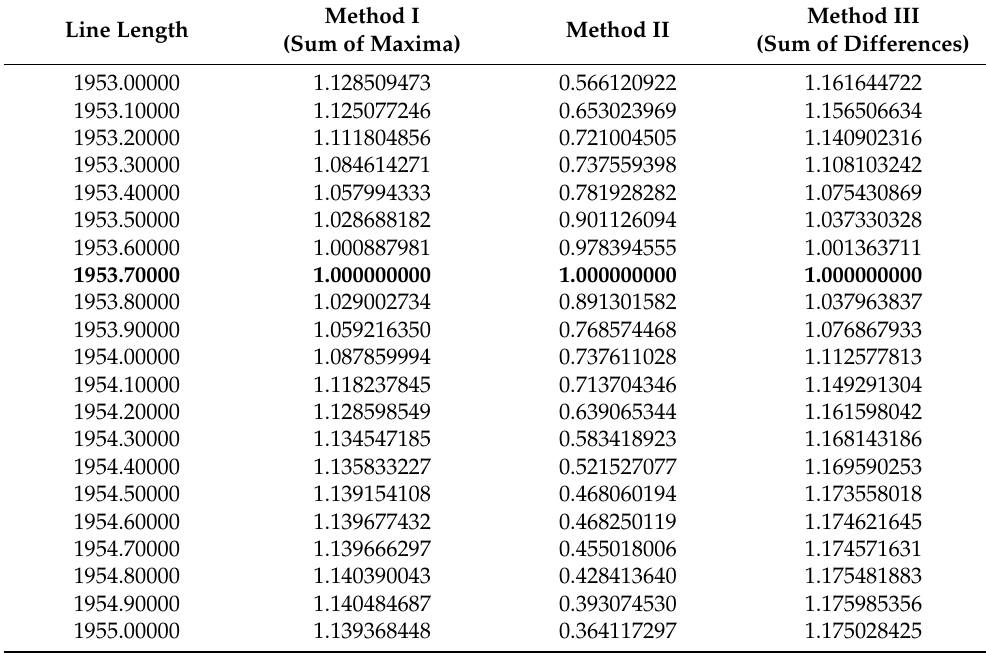
Table 4. Image line length estimation results for the accuracy ∆ = 0.1. Line